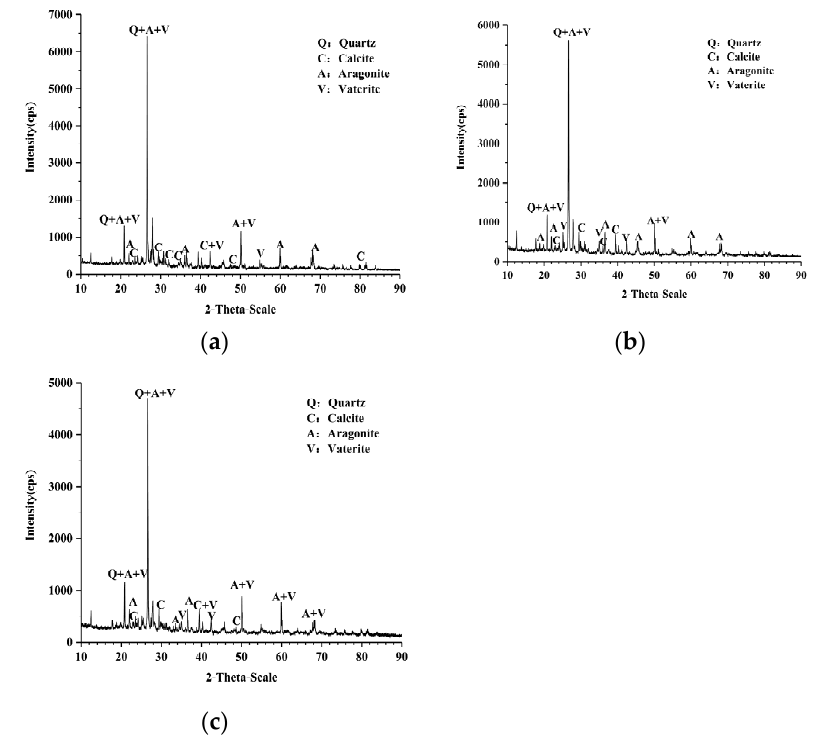
Figure 6. X-ray diffraction results of different silts. ( a ) X-Ray diffraction results of Silt A; ( b ) X-Ray diffraction results of Silt B; ( c ) X-Ray diffraction results of Silt C.